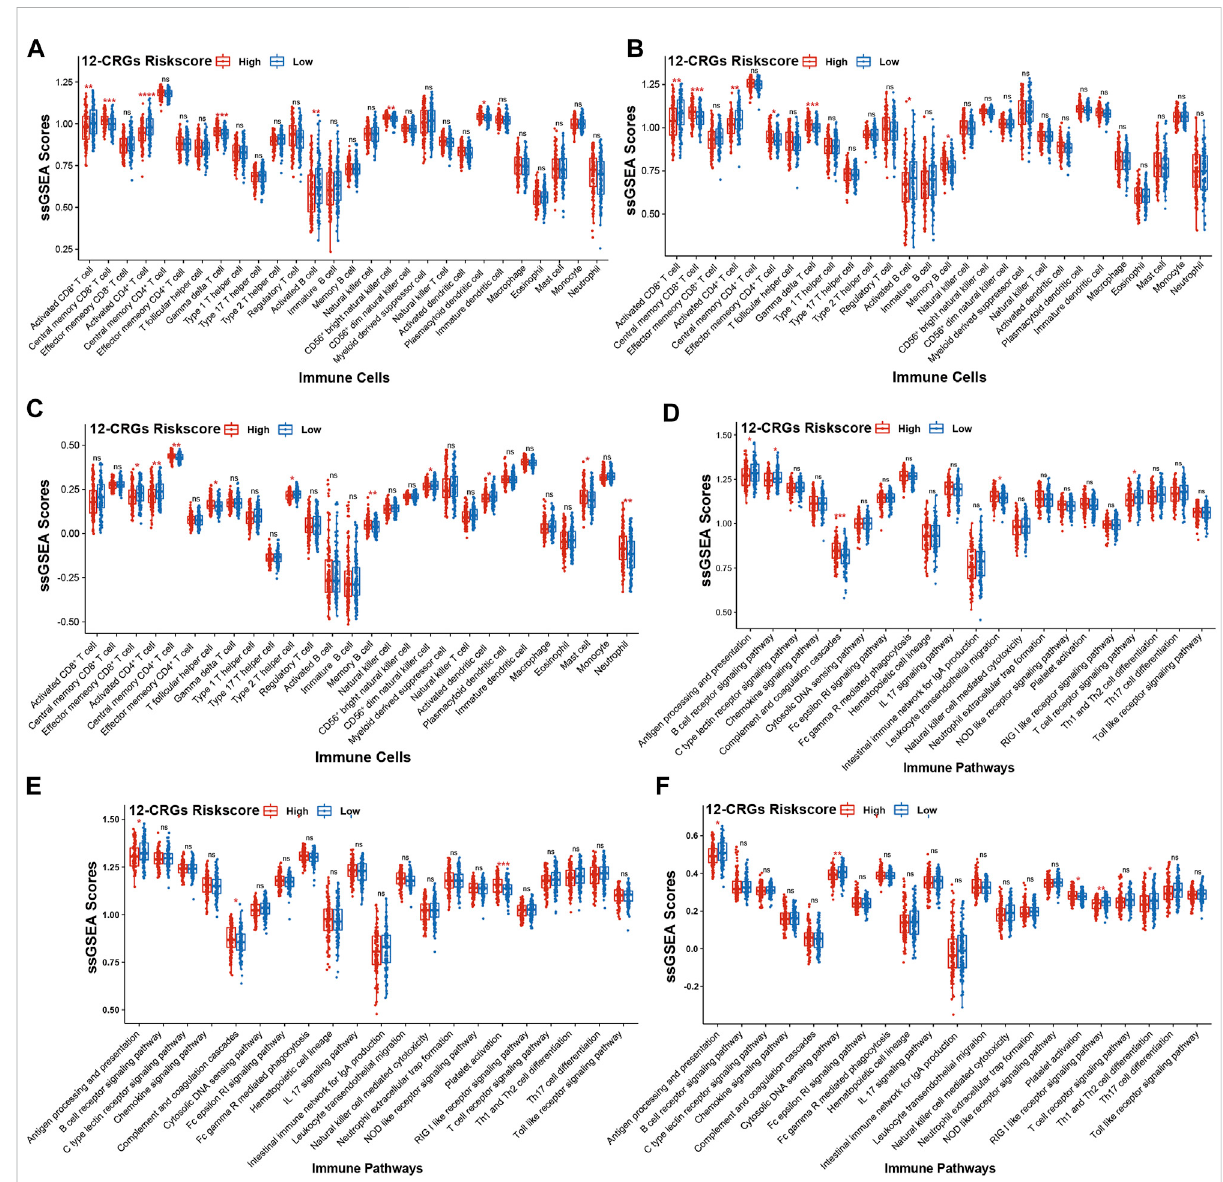
FIGURE 6 Association of the12-CRGs signature with immunestatus (A – C) Association of the12-CRGs signature with immune-related cells in TCGA- fi rst (A) , TCGA-second (B) and GSE65858 (C) cohorts (D – F) Association of the 12-CRGs signature with the immune-related pathways in TCGA- fi rst (D) , TCGA-second (E) and GSE65858 (F) cohorts. *p-value < 0.05; **p-value < 0.01; ** *p-value < 0.001; ****p-value <